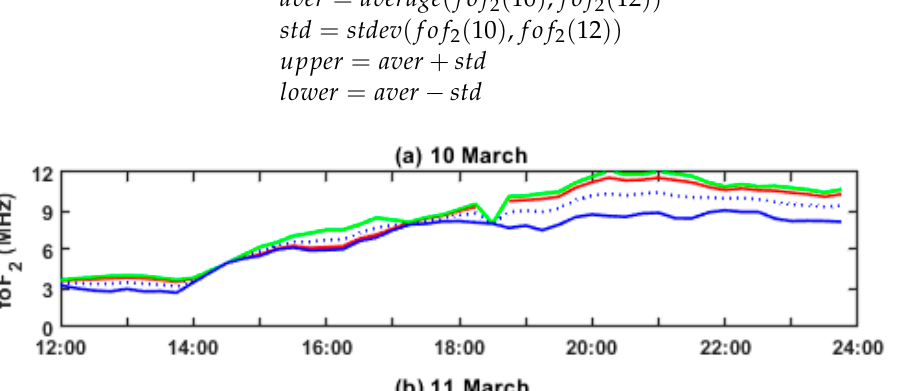
Figure 16. The difference between the upper value and the diurnal variation of the foF2 parameter in each epoch from 14:00 UT to 22:00 UT on March 11, 2011. 4.3.2. Using Electron Density Disturbances One of the techniques to obtain the ionospheric profiles of electron density is GPS radio occultation (RO). We used ionospheric electron density (IED) profiles obtained from F3/C RO measurements to detect the vertical ionospheric disturbances. The data are pro- vided by CDDAC (COSMIC Data Analysis and Archive Center, http://cdaac-www.cos- mic.ucar.edu-accessed in August 2020). Figure 17 shows the location of the ionospheric